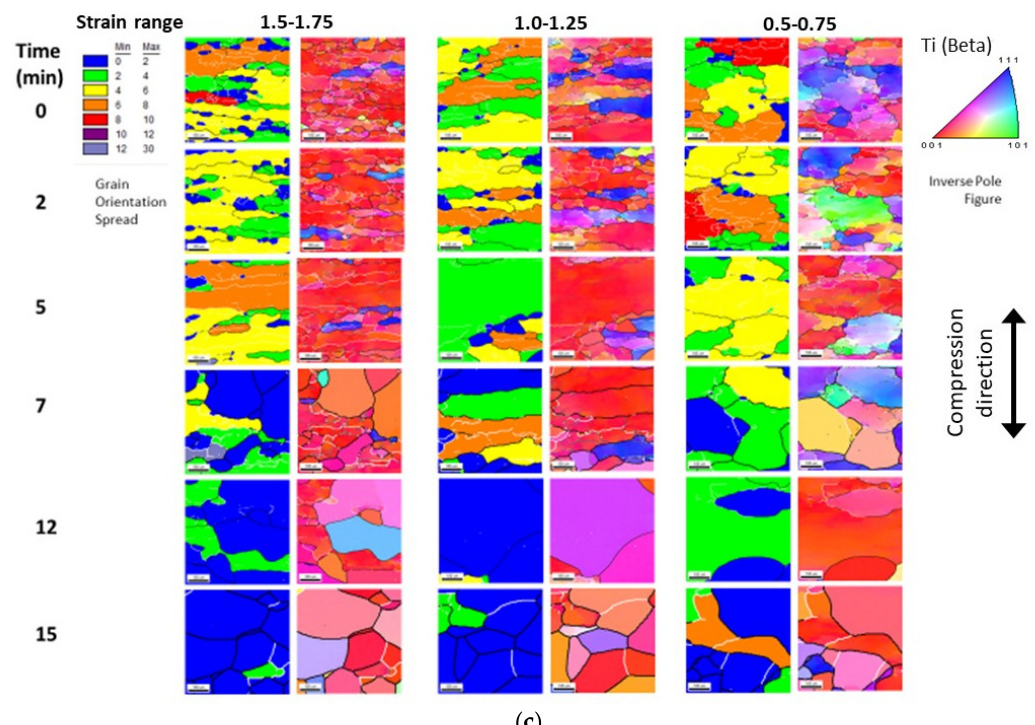
Figure 6. GOS and IPF maps showing the microstructure evolution of sample deformed with a nominal strain rate of ( a ) 1/s, ( b ) 0.1/s, and ( c ) 0.01/s, at the respective strain range after annealing at 950 °C for various time.